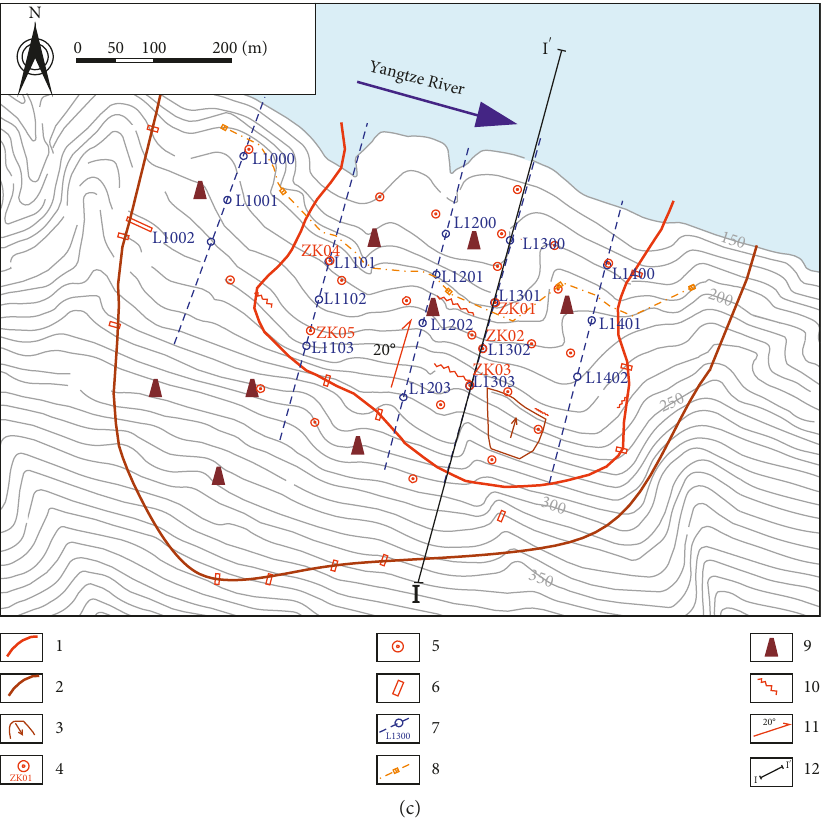
Figure 1: (a) Location, (b) overview, and (c) planar map of the Baishuihe landslide. (1) Boundary of the landslide based on the engineering geological exploration; (2) the predetermined boundary of the landslide; (3) small collapse; (4) borehole drilled by China University of Geosciences, Wuhan; (5) borehole drilled by Sanxia University; (6) exploratory trench; (7) SNMR survey points and survey line; (8) distributed optical fiber sensor deformation monitoring; (9) GPS monitoring points; (10) ground surface fissures; (11) sliding direction; (12) cross-sectional